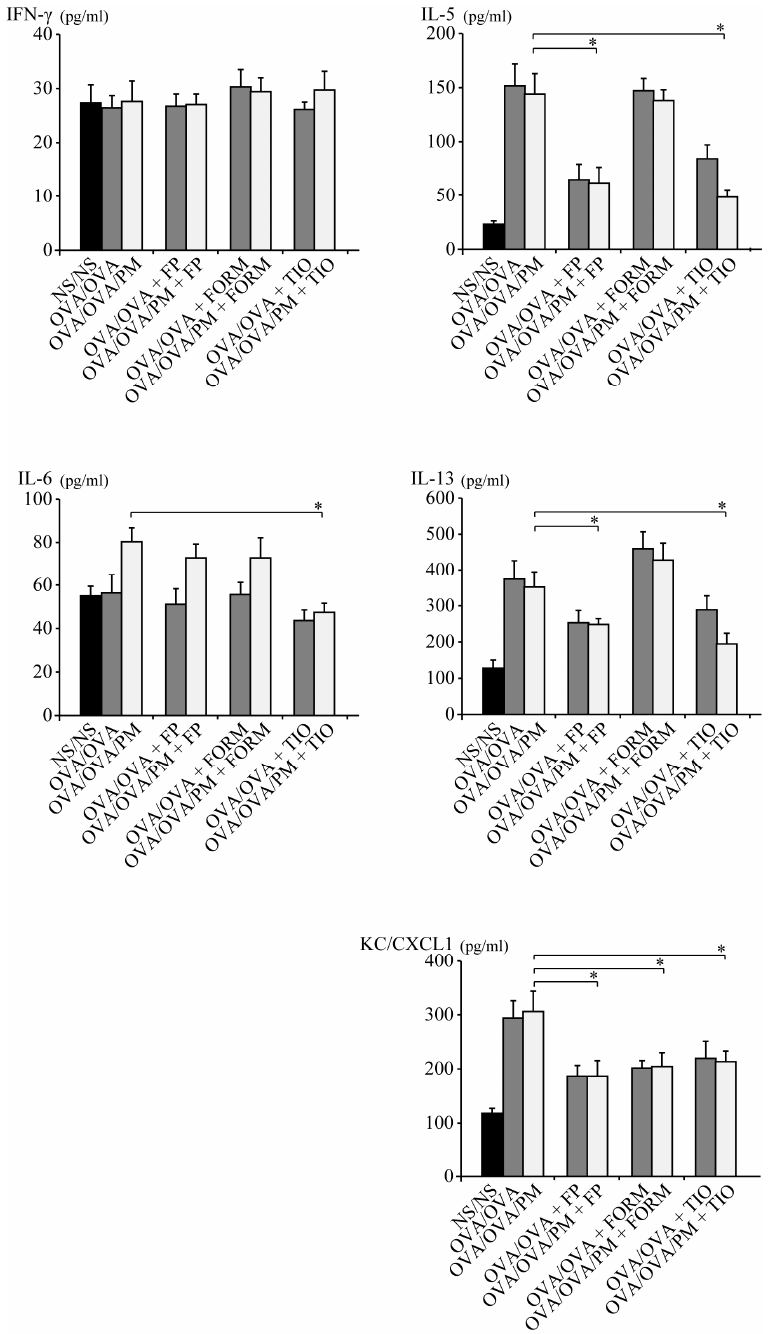
Figure 3. Cytokine concentrations in bronchoalveolar lavage fluid (BALF). BALF cytokine expression profiles were analyzed using enzyme immunoassays for IFN- γ , IL-5, IL-6, IL-13, and KC/CXCL1. Data for each group are expressed as the mean ± standard deviation, with six mice per group. * p < 0.05.